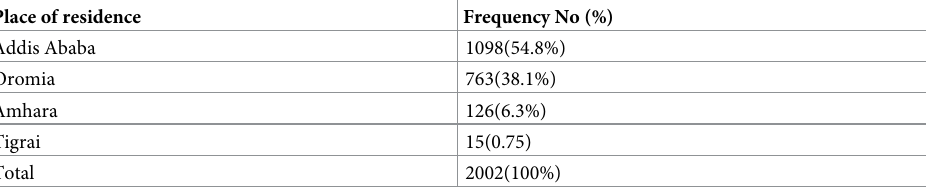
Table 1. Distribution of breast and gynecological cancers presenting at SPHMMC by place of residence 2014–18.